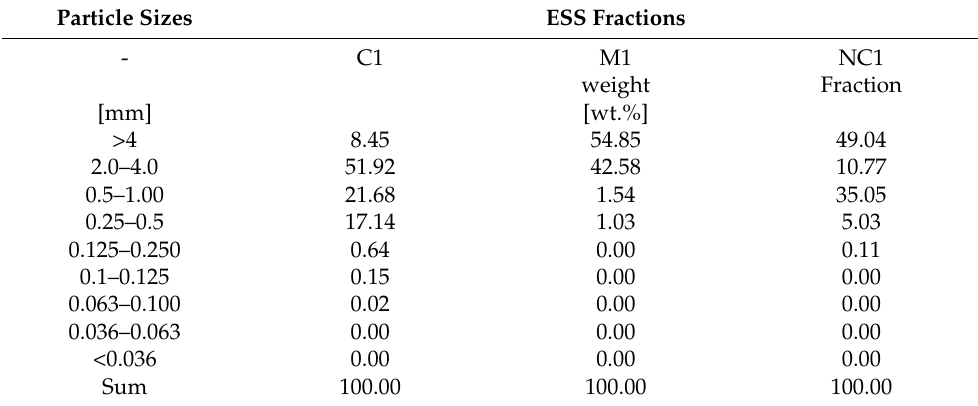
Table 3. Particle sizes distribution of ESS